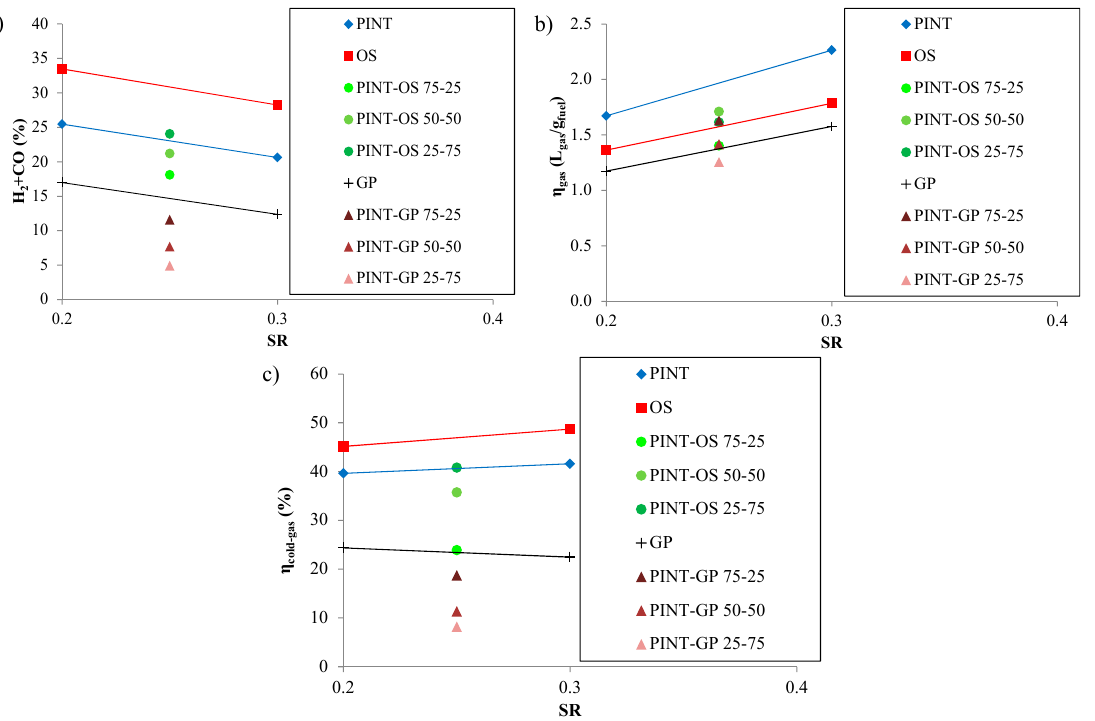
Figure 5. Combustion profiles, expressed as the derivative thermogravimetric (DTG) of the samples.